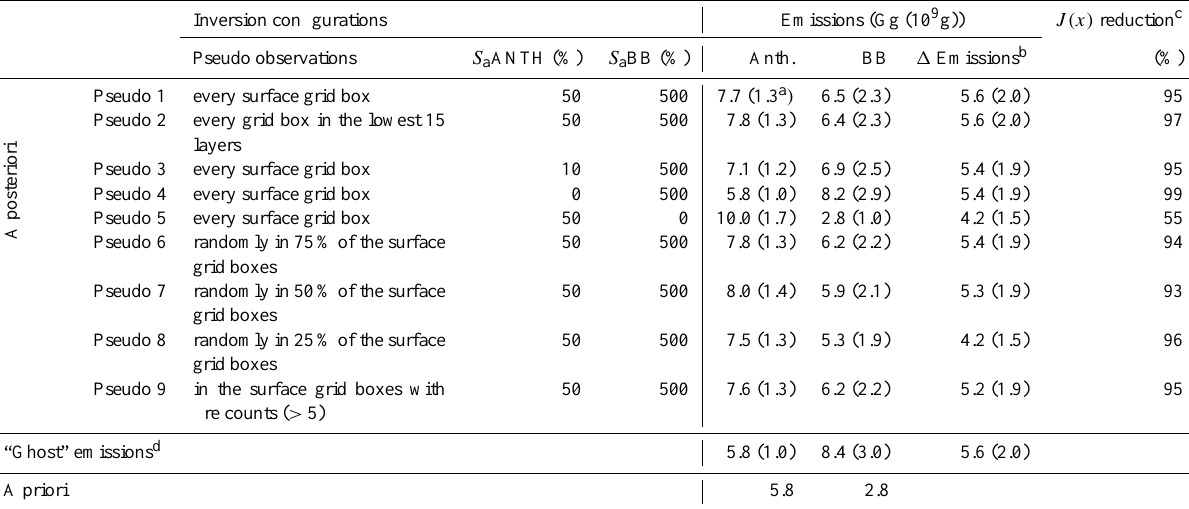
Table 2. Monthly anthropogenic and biomass burning emissions of BC (unit: Gg) in the WUS from the adjoint inversions for August 2006 using pseudo observations.